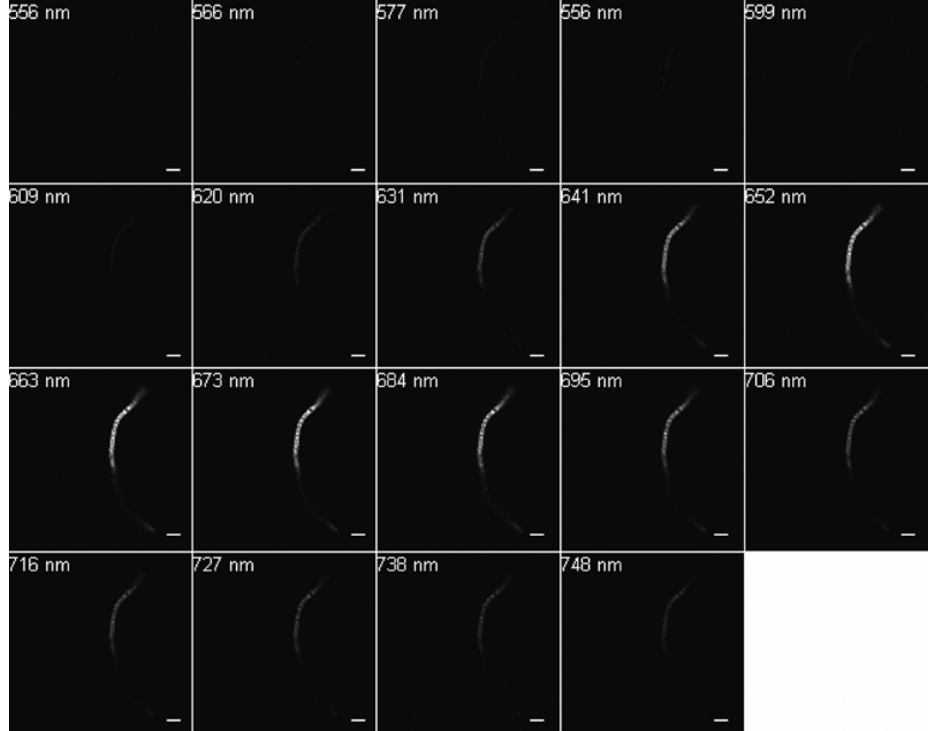
Figure 6. Spectral emission collection of SF33 RL-grown cells after excitation with 543-nm laser. An emission spectrum was gathered at 10.7-nm increments in the range from 550 nm to 750 nm. All images at 63× oil objective. Bars, 10